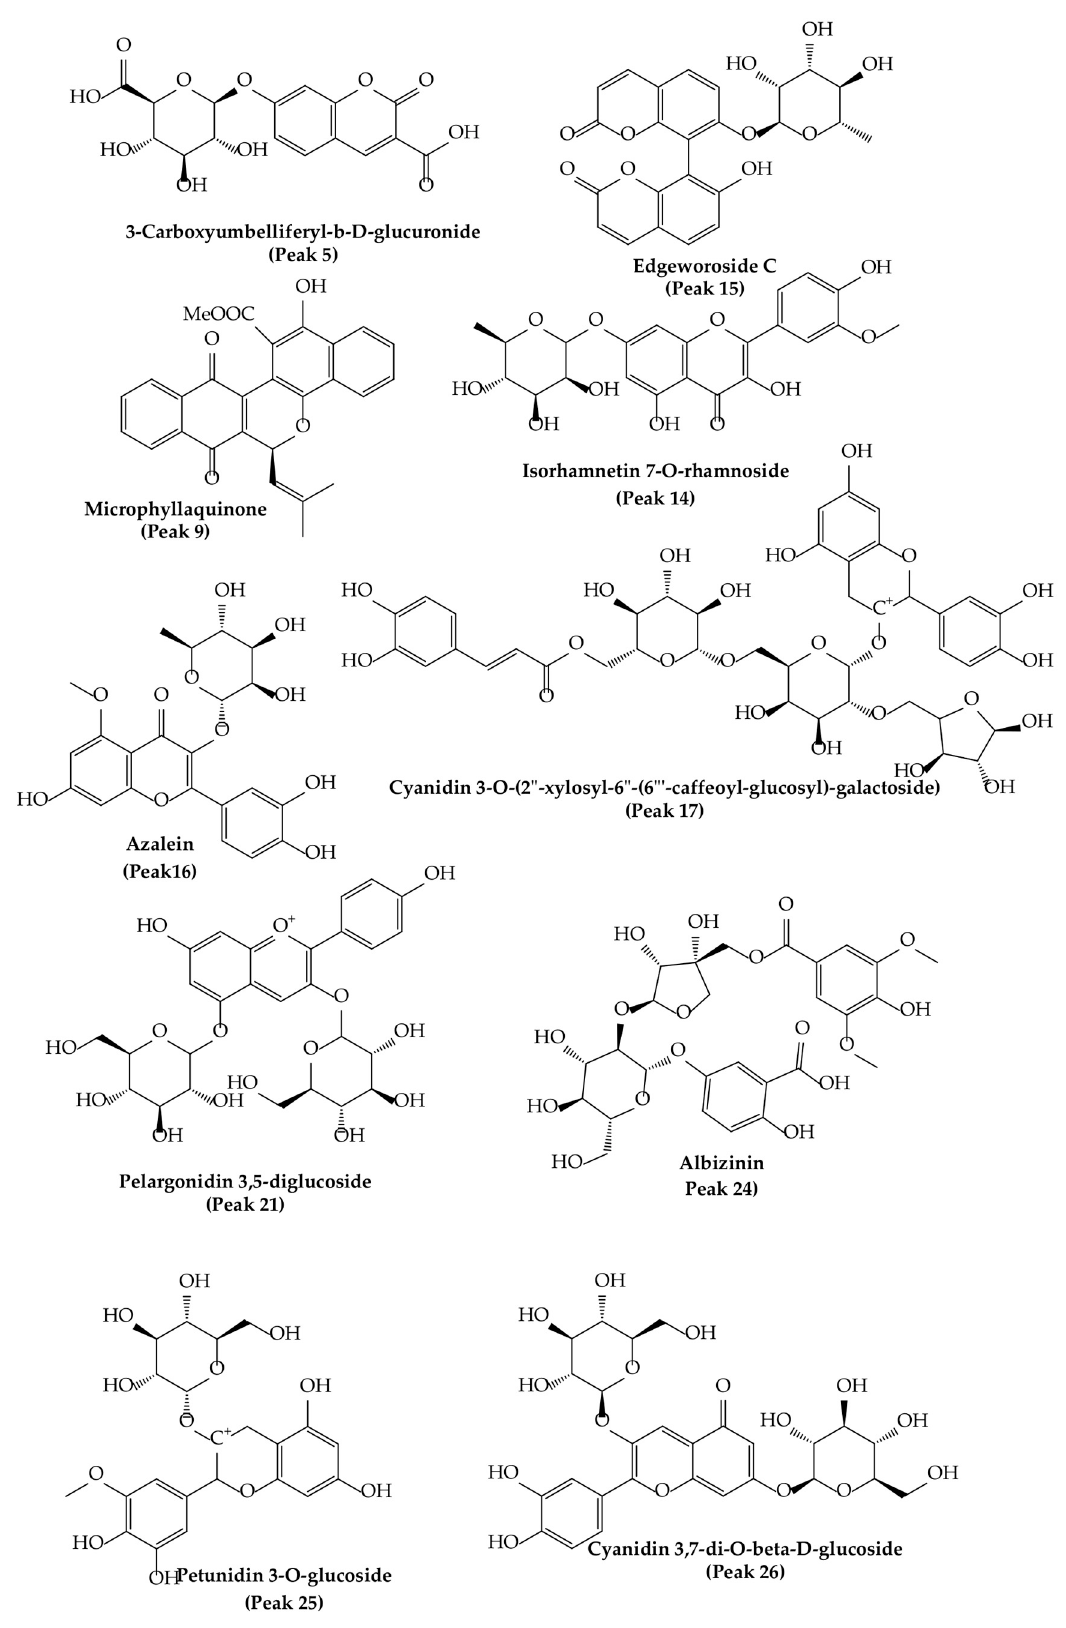
Figure 3. Molecular structures of some main compounds detected via HPLC-MS on A. dentata fruits.